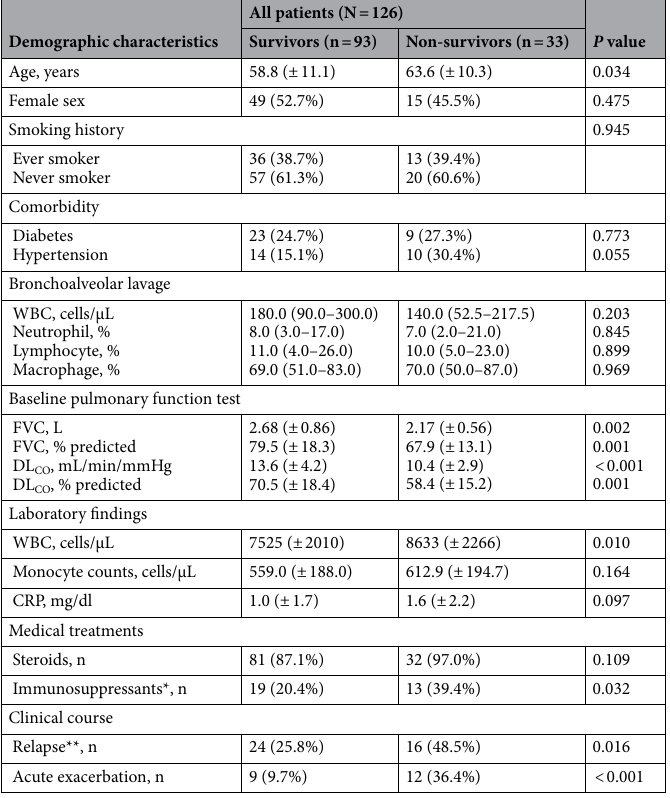
Table 2. Comparison of characteristics between the survivors and non-survivors among the patients with idiopathic nonspecific interstitial pneumonia. Data are expressed as the mean (± standard deviation), median (interquartile range), or counts (%). FVC, forced vital capacity; DL CO , diffusing capacity of the lung for carbon monoxide; WBC, white blood cells; CRP, C-reactive protein. *Medication including azathioprine, mycophenolate mofetil, or tacrolimus. **Deterioration of clinical course including lung function, symptoms, or radiologic findings and re-prescribed steroids with or without immunosuppressants.